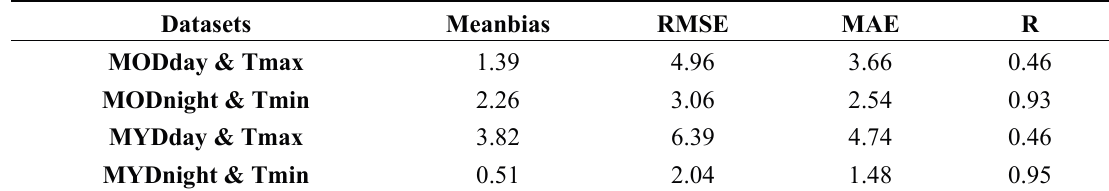
Table 1. Statistics with direct using of daily MODIS Ts products as estimators of Ta observations